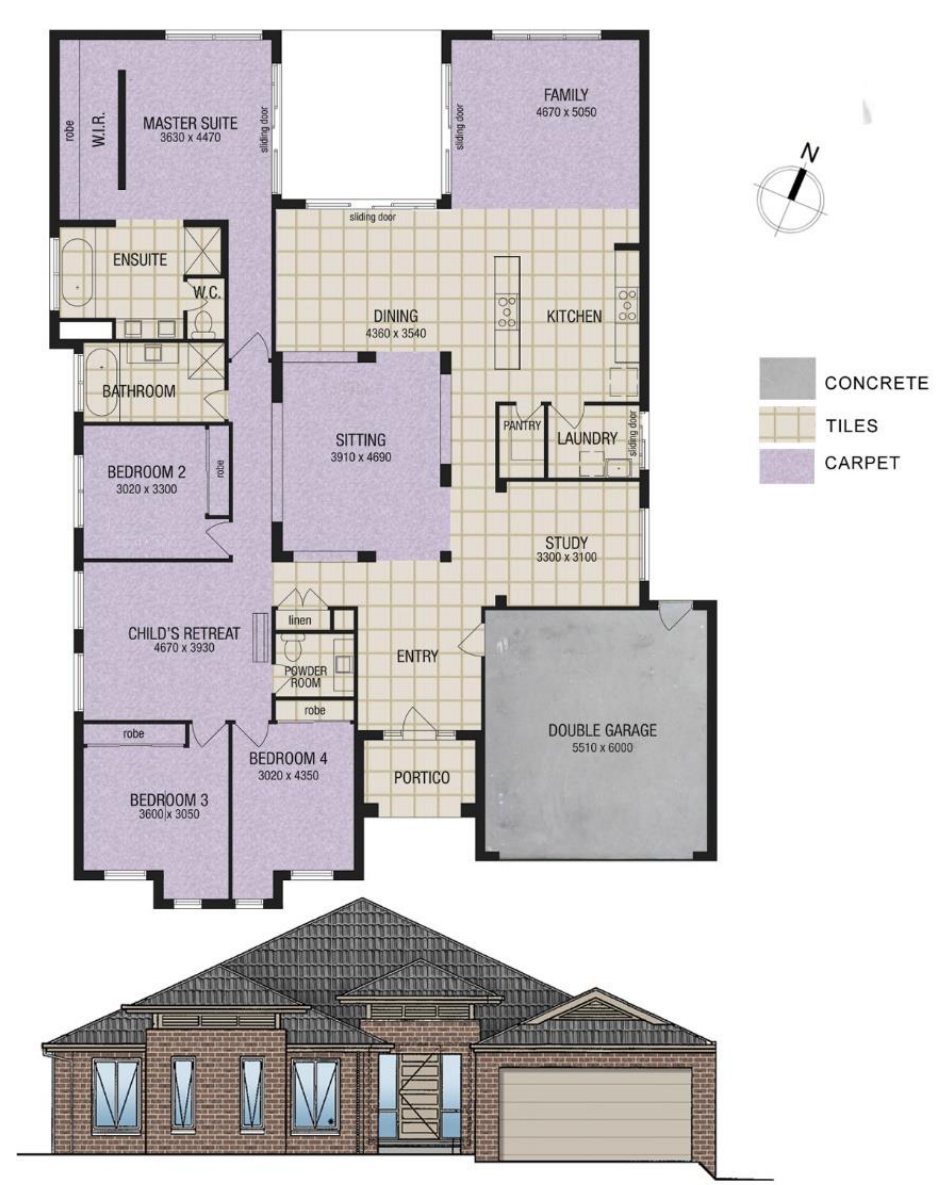
Figure 2. Floor plan and elevation of the case study house.